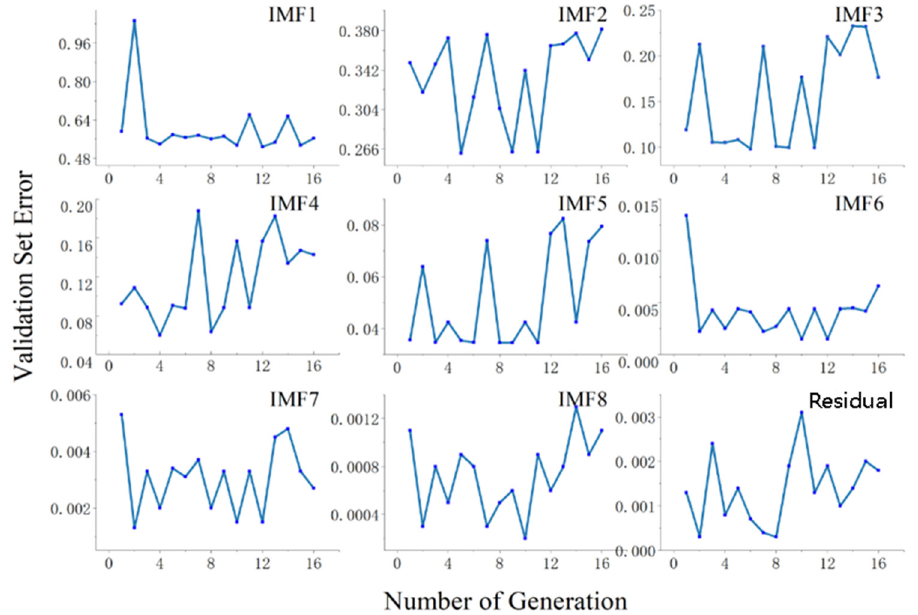
Figure 5. Propagation-loss subsequence validation set error and generated iteration (evaporation duct).